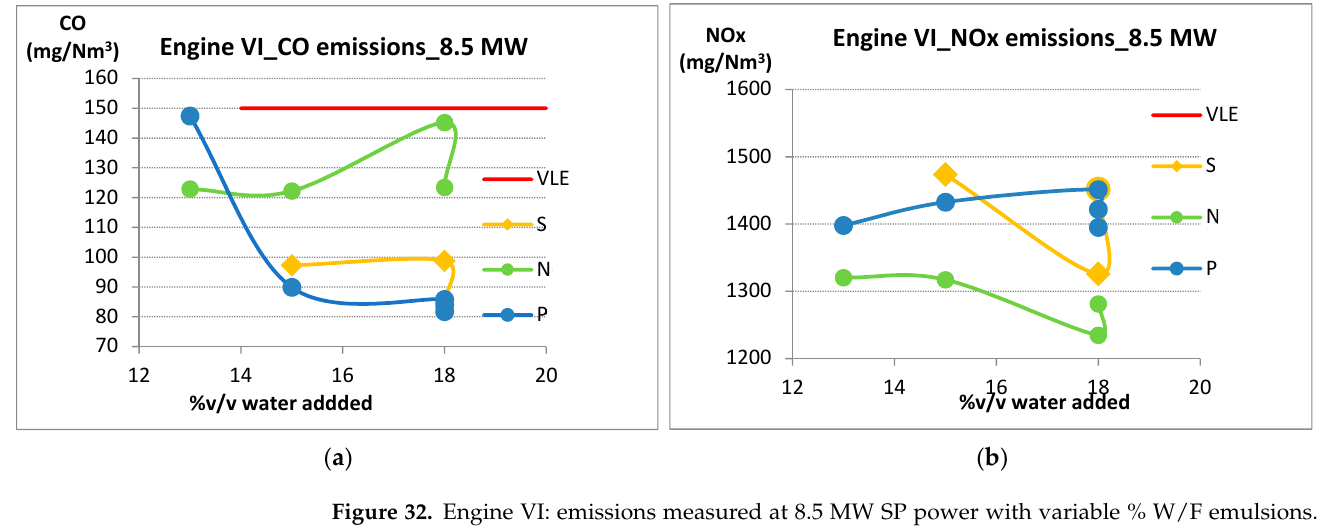
Figure 32. Engine VI: emissions measured at 8.5 MW SP power with variable % W/F emulsions. ( a ) CO emissions; ( b ) NOx emissions.